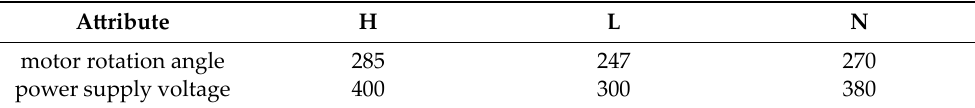
Table 4. Attribute reference